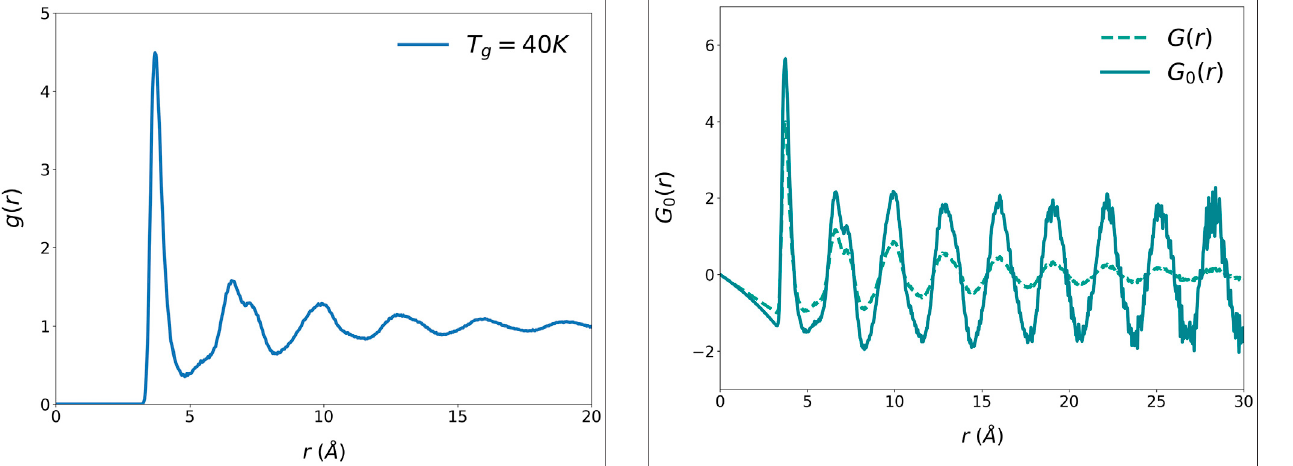
FIGURE 1 | The PDF, g ( r ), of liquid Argon at T g = 40 K.